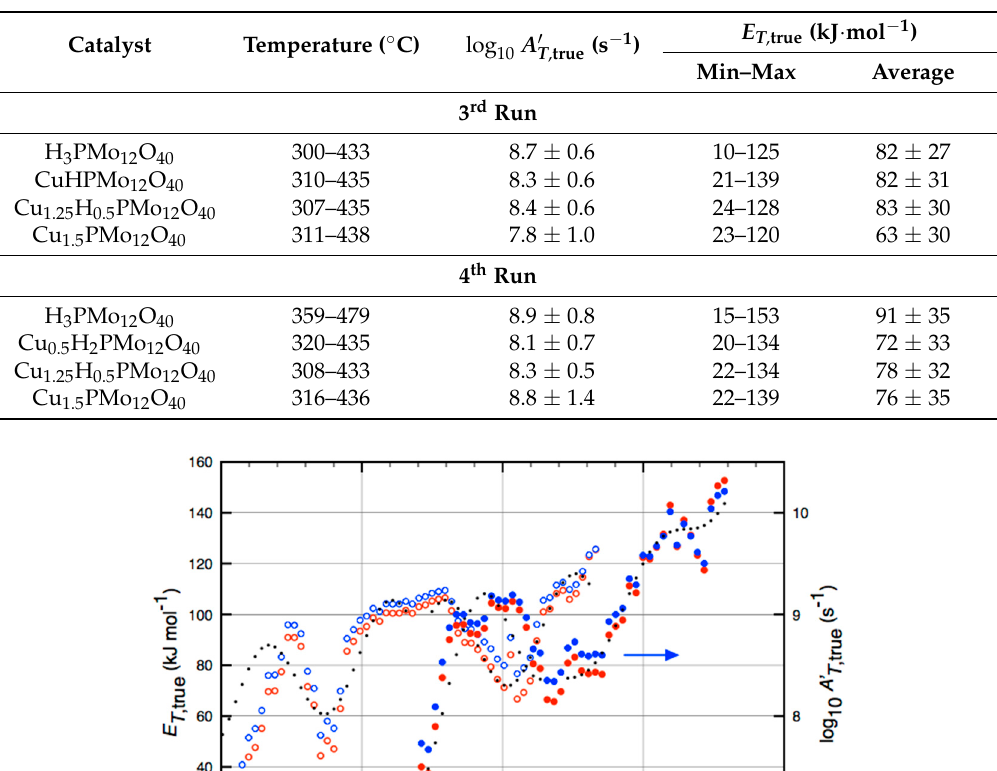
Table 2. Range of and average activation energies and prefactors for the selective oxidation of isobutane to methacrolein over phosphomolybdic acid, copper(II) phosphomolybdates and mixed copper/Brønsted acid catalysts in the high-temperature region.